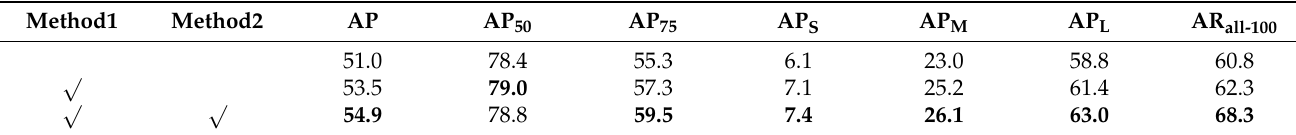
Table 4. Combination experiment of two improved